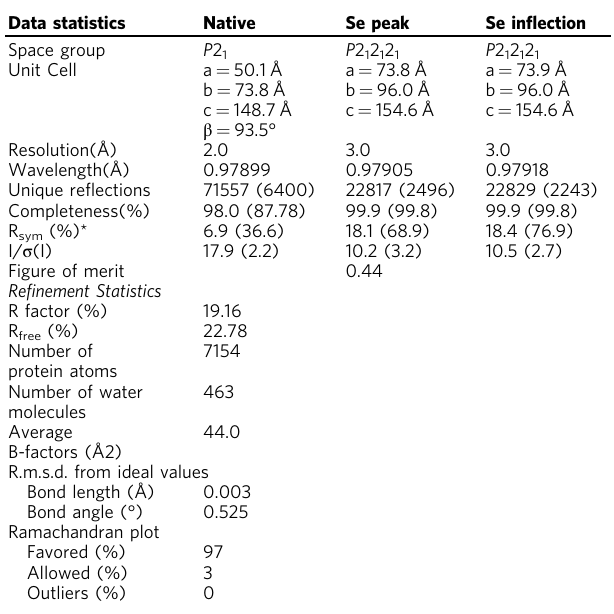
Table 1 Summary of 2-HIS data collection and re fi nement statistics.